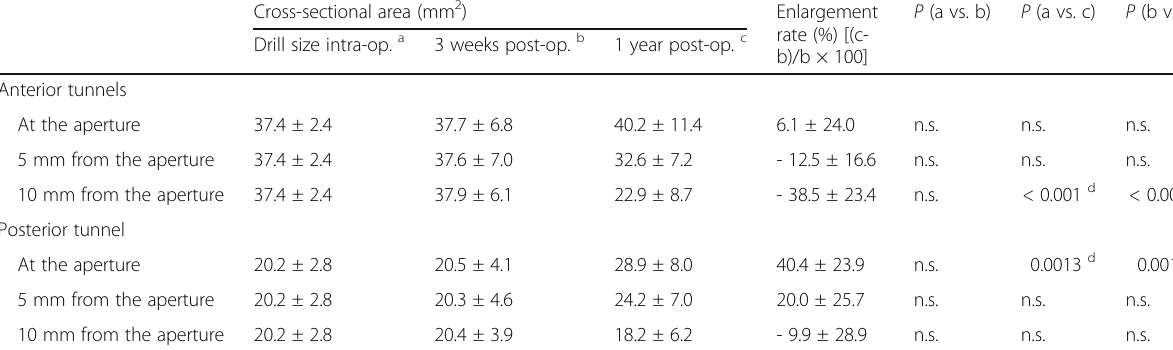
Table 1 Cross-sectional area and enlargement rate in the tibial